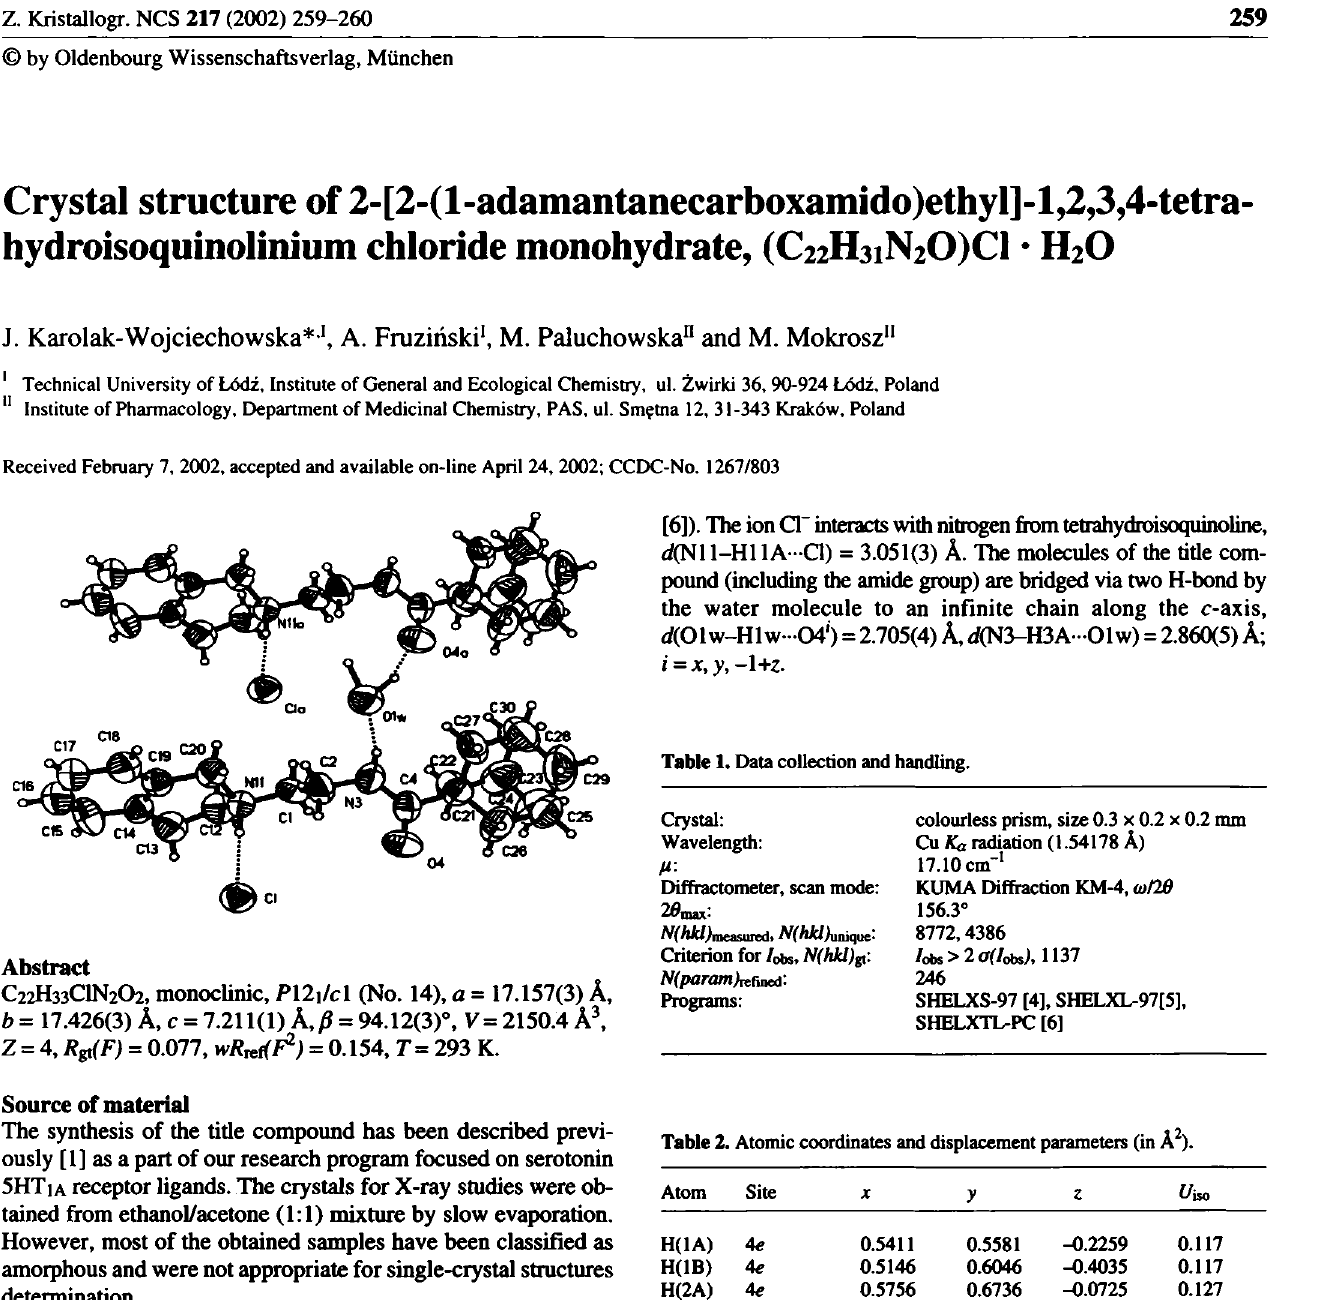
Table 2. Atomic coordinates and displacement parameters (in A 2